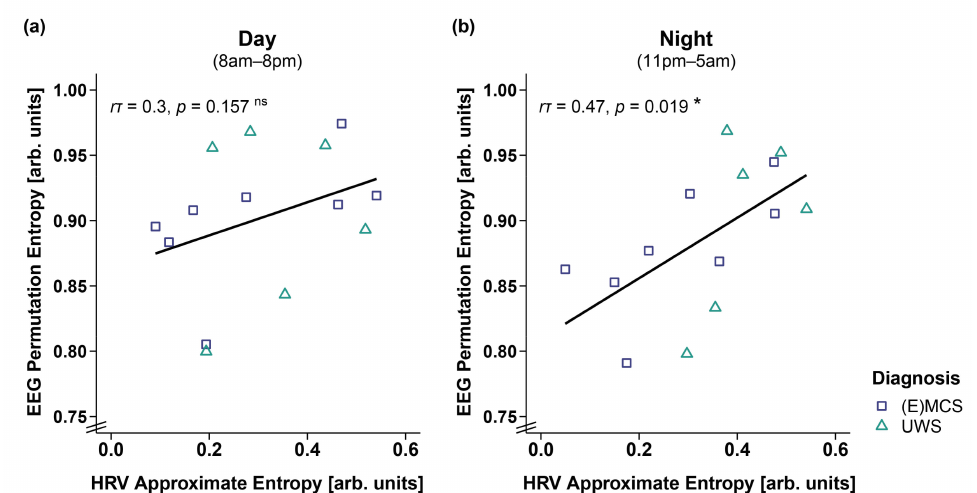
Figure 7. Correlation between EEG permutation entropy (PE) and HRV approximate entropy (ApEn) separately for day and night. ( a ) While EEG PE and HRV ApEn did not correlate during the day (i.e., 8 a.m.–8 p.m.), ( b ) a higher EEG PE was associated with a higher HRV ApEn during the night (i.e., 11 p.m.–5 a.m.). * p < 0.05; ns = not significant. Abbreviations: (E)MCS = (emergence from) minimally conscious state; UWS = unresponsive wakefulness syndrome; arb. units = arbitrary